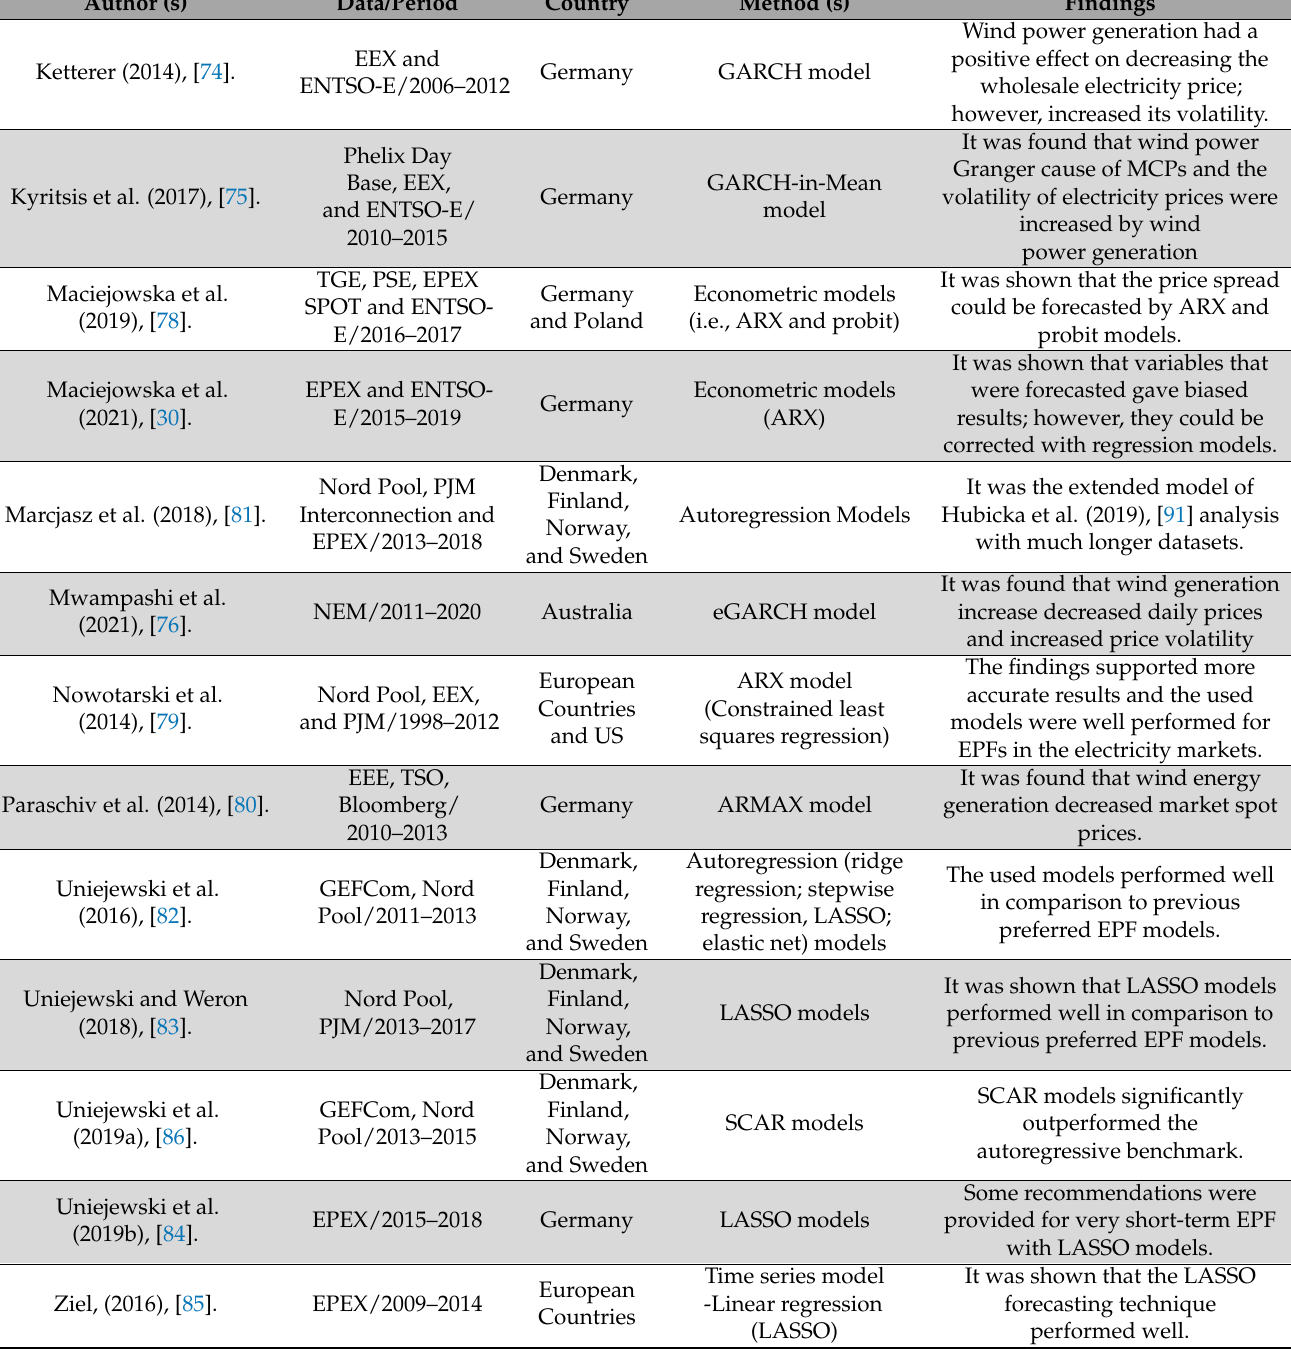
Table 3. A literature review through statistical models (second-part) on electricity market price and load forecasting through wind